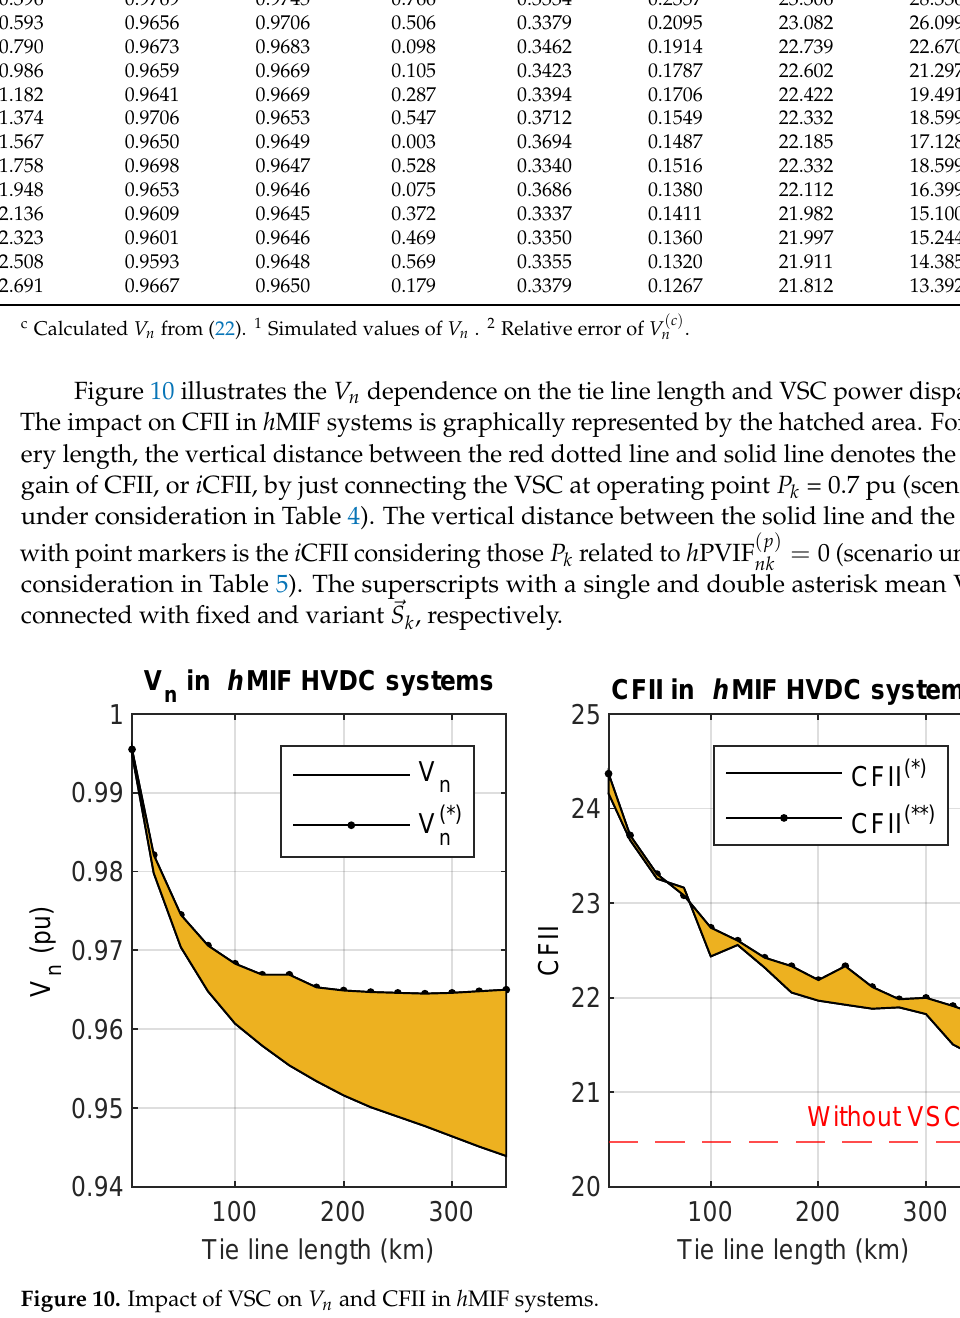
Figure 10. Impact of VSC on V n and CFII in h MIF